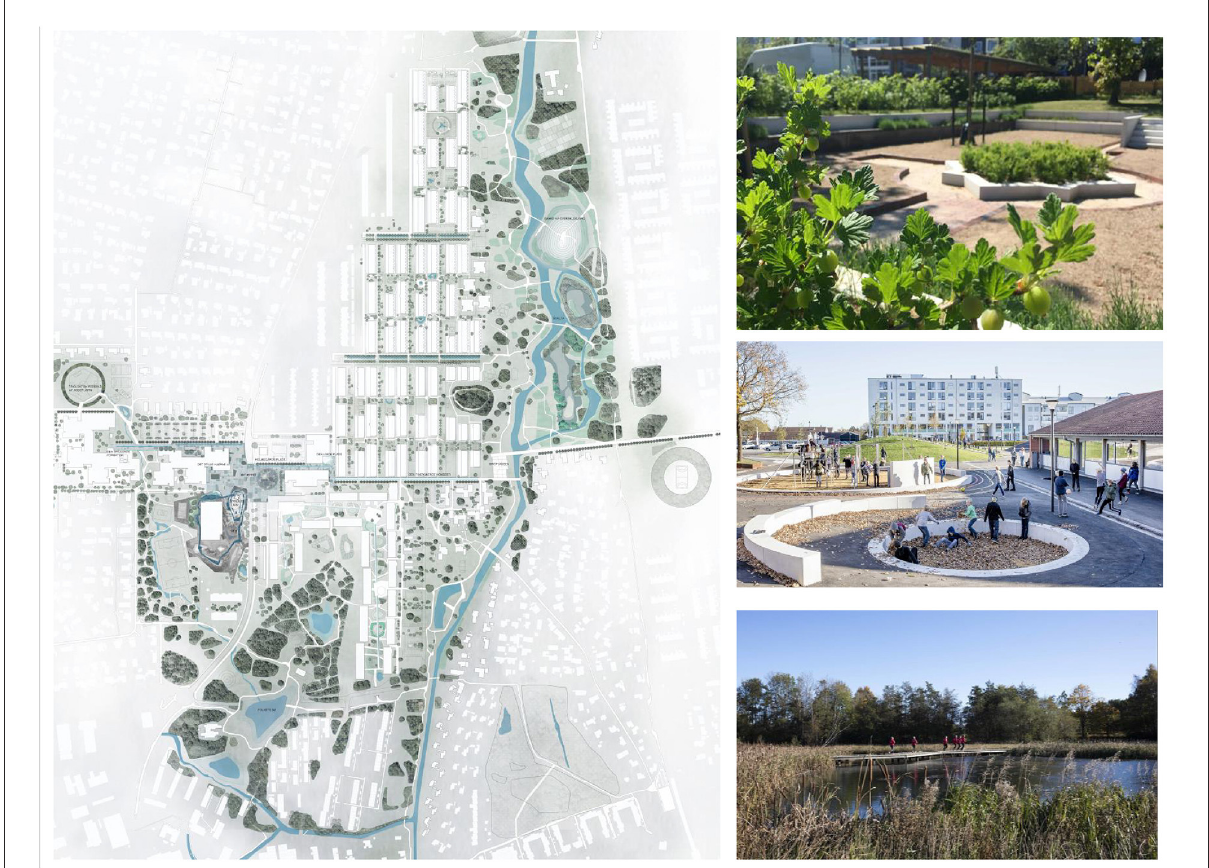
FIGURE3 Masterplan and photos from Kokkedal river restoration and storm water adaptation project. (Left) Master plan (SCHÖNHERR landscape architects). (Top Right) The Moroccan Garden (Ole Fryd). (Middle Right) New integrated play space and retention (Realdania/Ingemann Ørnstrup). (Bottom (Right) New access to riverine nature (Realdania/Ingemann